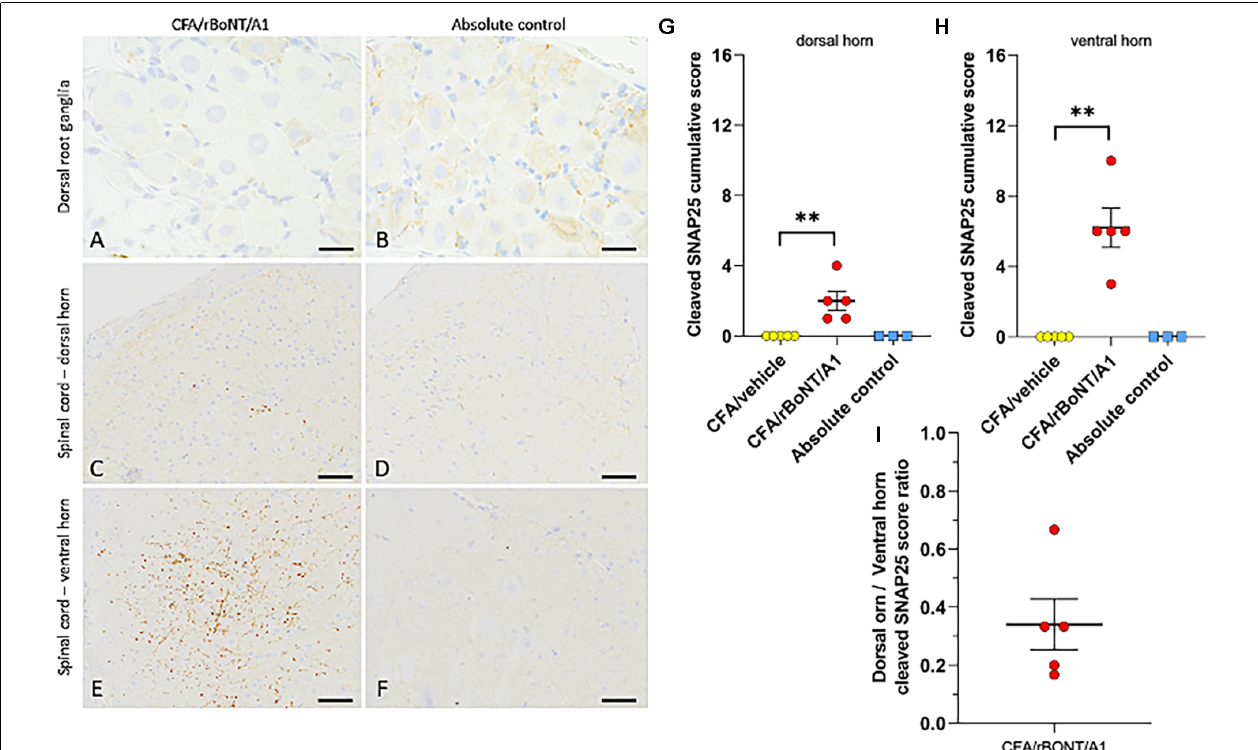
FIGURE 8 | Cleaved SNAP25 in the dorsal root ganglion (DRG) and the lumbar spinal cord. (A,B) Representative images of the dorsal root ganglion (DRG) and (C–F) of the spinal cord of mice treated with CFA/rBoNT/A1 or in untreated controls. Cleaved SNAP25 was absent in the DRG (despite higher background staining), while being present in the nerve ending-like structures in the ipsilateral dorsal (C) and ventral (E) horns of the lumbar spinal cord of CFA/rBoNT/A1-treated animals, but not in absolute controls. Bars (A,B) (20 µ m), (C–F) (50 µ m). (G–I) Quantification of cleaved SNAP25 in the lumbar spinal cord in CFA/rBoNT/A1-treated animals compared to CFA/vehicle and absolute controls. c-SNAP25 staining was moderate in the dorsal horn (G) and high in the ventral horn of the spinal cord (H) while being absent in CFA/vehicle-treated animals and in absolute controls. (I) The dorsal horn/ventral horn ratio of c-SNAP25 ( < 1) indicates higher targeting of ventral vs. dorsal horn by rBoNT/A1. N = 5/group (CFA/rBoNT/A1, CFA/vehicle) and N = 3 (absolute control). Mean ± SEM. ∗∗ p < 0.01 CFA/rBoNT/A1 vs. CFA/vehicle; Mann-Whitney